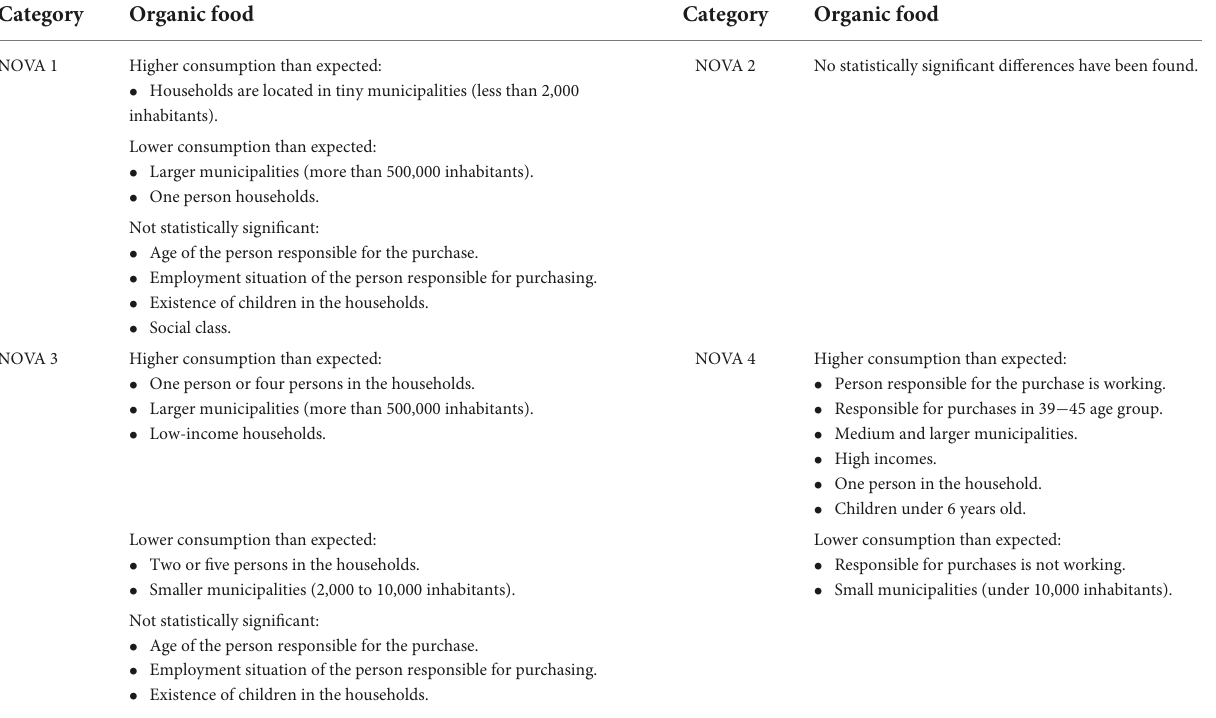
TABLE 6 Summary of results of NOVA organic food crosses with socio-demographic variable. Category Organic food Category Organic food NOVA 1 NOVA 2 No statistically significant differences have been